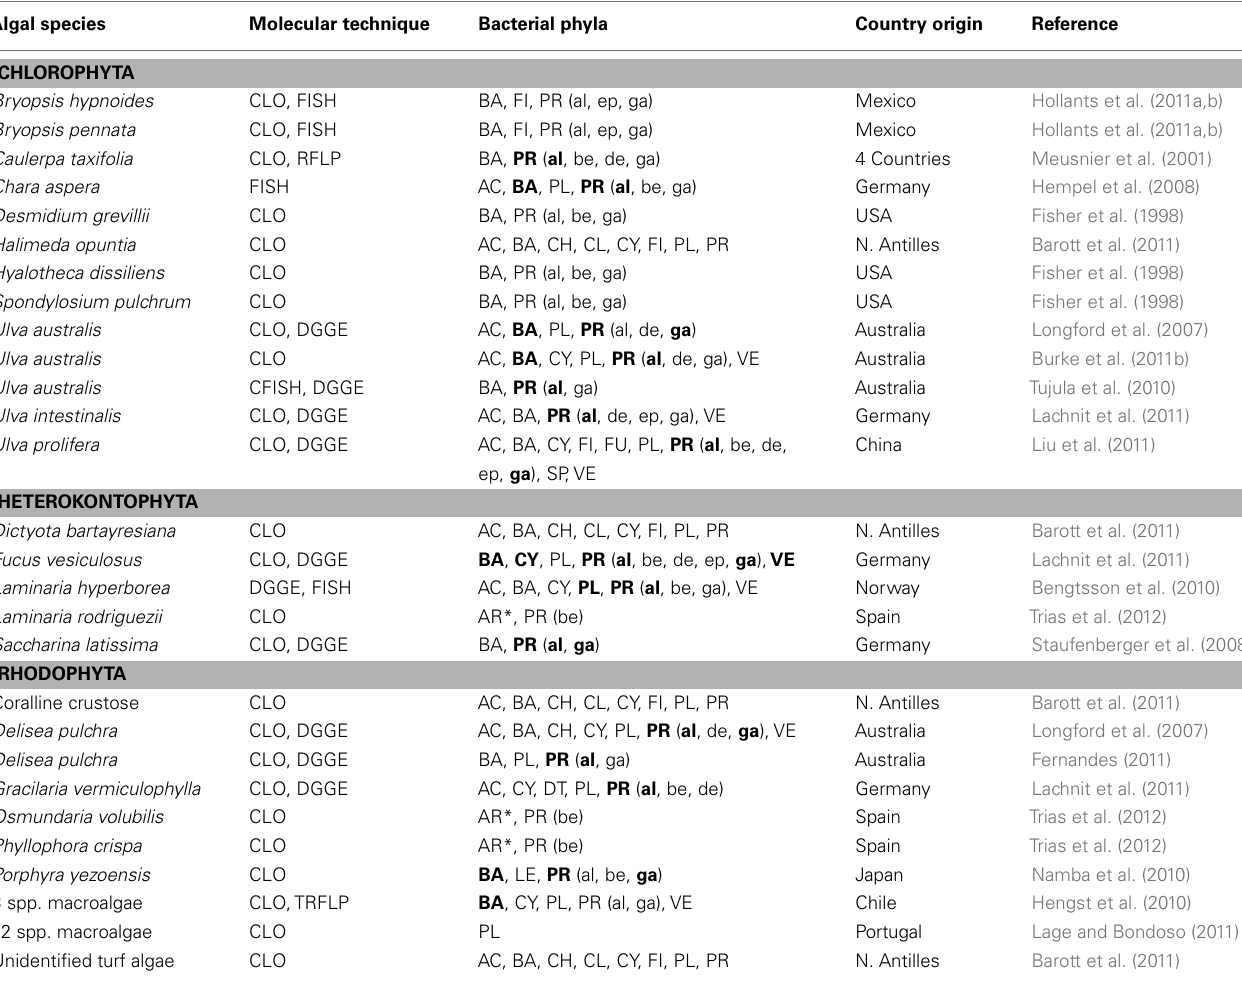
Table 1 | Phylogenetic studies of the bacterial communities associated with